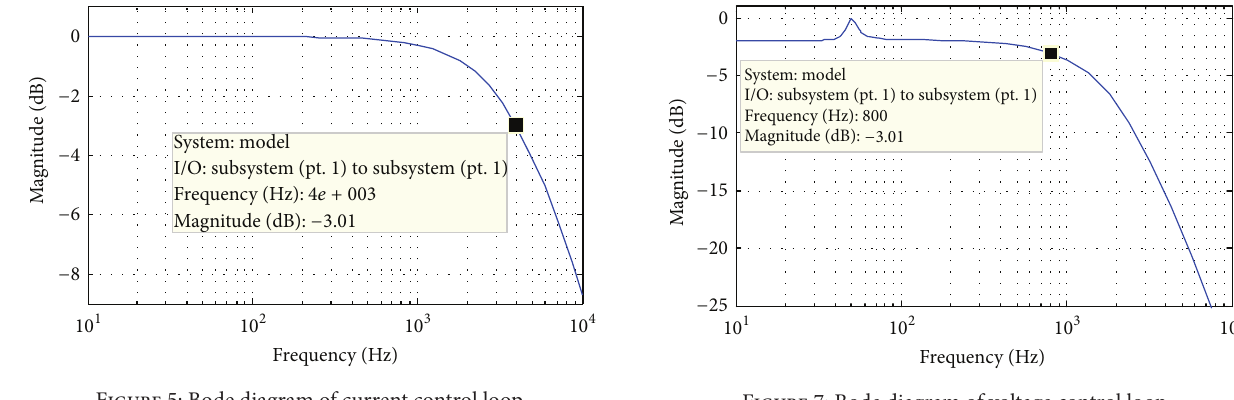
Figure 7: Bode diagram of voltage control loop.